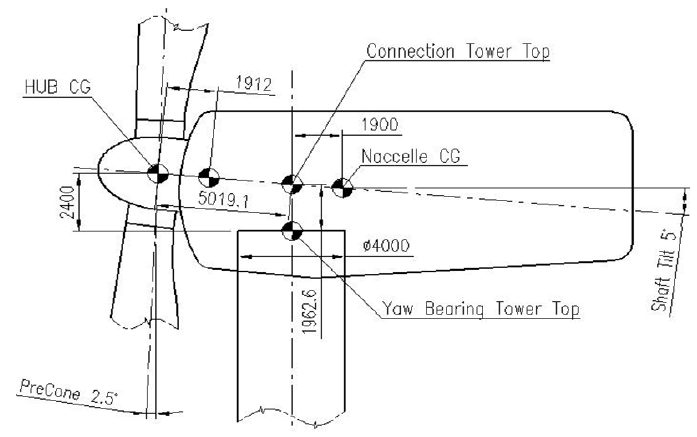
Figure 4. RNA of the NREL 5-MW baseline offshore wind turbine.